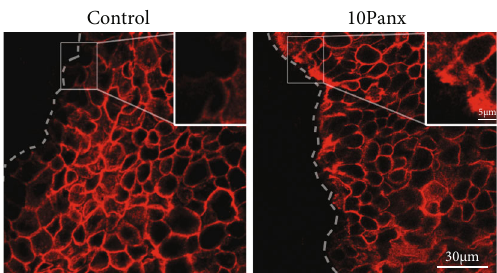
Figure 2: Pannexin1 mediates corneal epithelial sheet migration. Representative images of B6 control corneas (in the presence of 10Panx or a scrambled control (control) peptide) wounded, incubated for 2hrs in medium, fi xed, and then stained with rhodamine phalloidin. The inset highlights the di ff erences in actin at the leading edge and demonstrates coalescence of actin in the 10Panx treated corneas. Bar equals 30 microns. N is a minimum of 3 independent